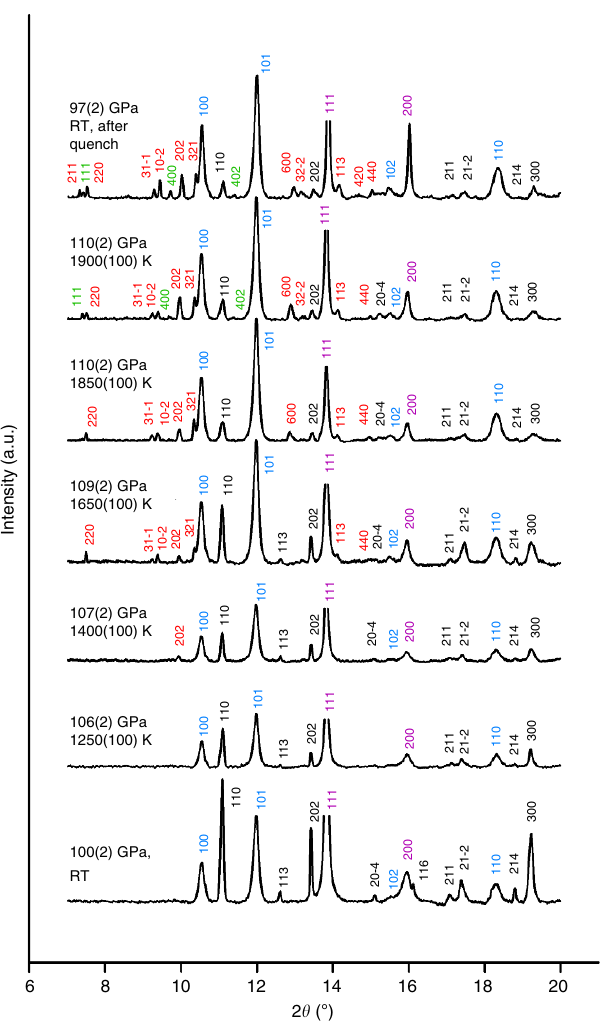
Figure 5 | Selected integrated X-ray diffraction patterns collected on heating of FeCO 3 near or above 100GPa. Patterns are labelled with the pressure and temperature during data collection. Indices of different phases are coloured as follows: FeCO 3 starting material (black), Ne (magenta), Re (light blue), tetrairon(III) orthocarbonate Fe 4 C 3 O 12 (red) and diiron(II) diiron(III) tetracarbonate Fe 4 C 4 O 13 (green). Neon was used both as a quasi- hydrostatic pressure medium and a pressure standard (Methods section). Data were collected at ID09a at ESRF with an X-ray wavelength of